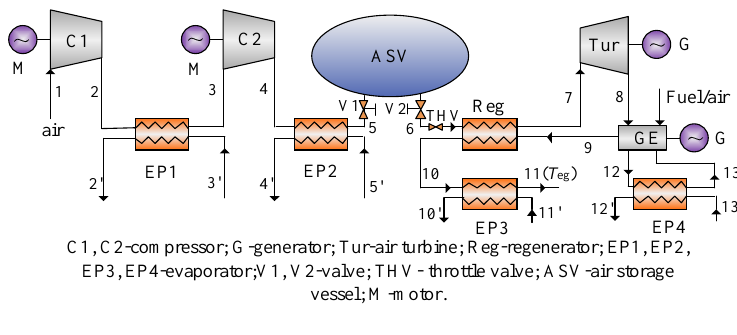
Figure 1. Schematic diagram of the CAES system.